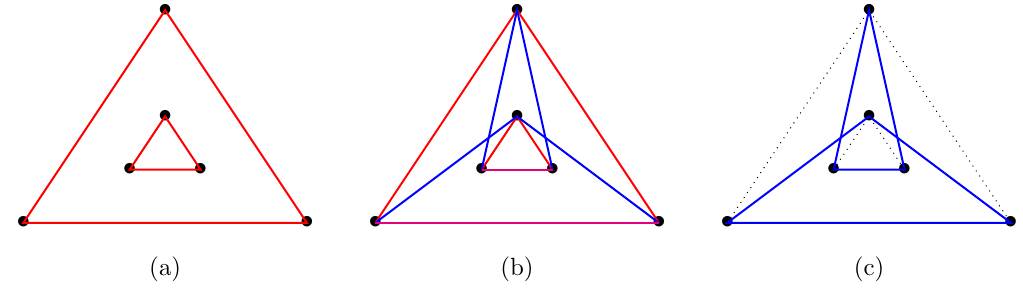
Figure 7. C [ (cid:22) R ] and C [ (cid:22) L ] brane plus intra and inter-brane Higgs. Here, we display example solutions involving only two triangular con(cid:12)guration. There exists a continuously parametrized solution interpolating between (a) and (c), while all intermediate states can be thought of as in (b). As before legs depicted with the same color have the same